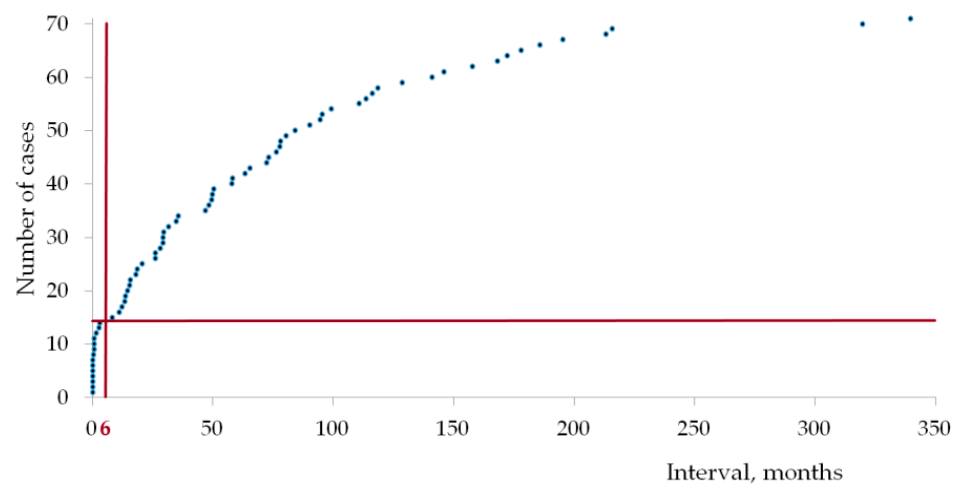
Figure 3. Intervals between the previous and the next malignancy. Two intervals per case are considered for triple primary malignancies.